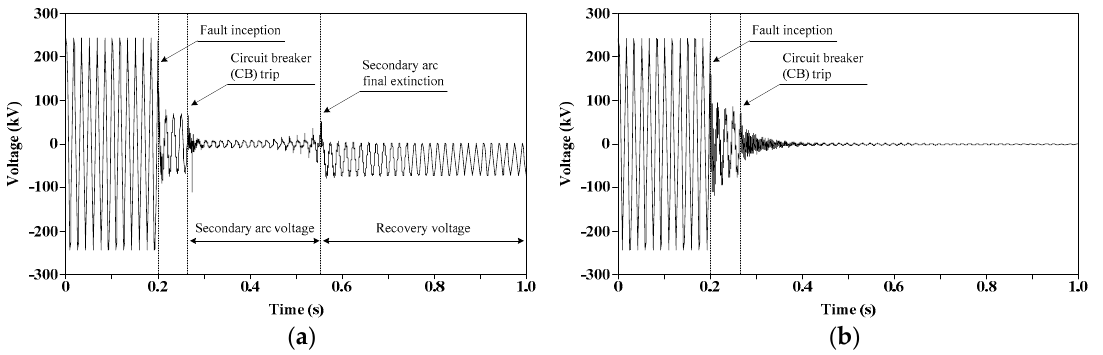
Figure 4. Voltage waveform of the faulted phase: ( a ) transient fault; ( b ) permanent fault.